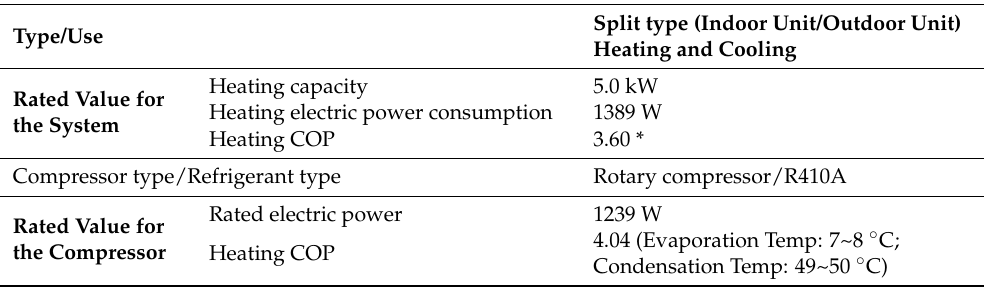
Table 1. Global performance of heat-pump system.